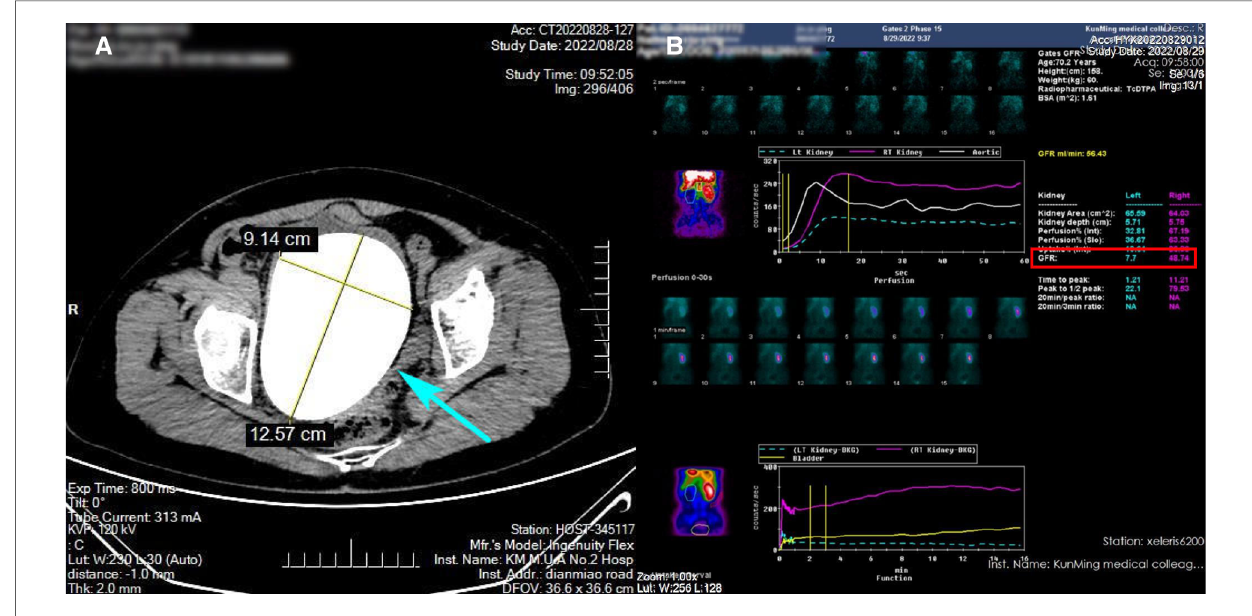
FIGURE 1 Computed tomography scan showing a neobladder stone ( A , blue arrow). A renal scan showing poor blood perfusion in the left kidney ( B ).